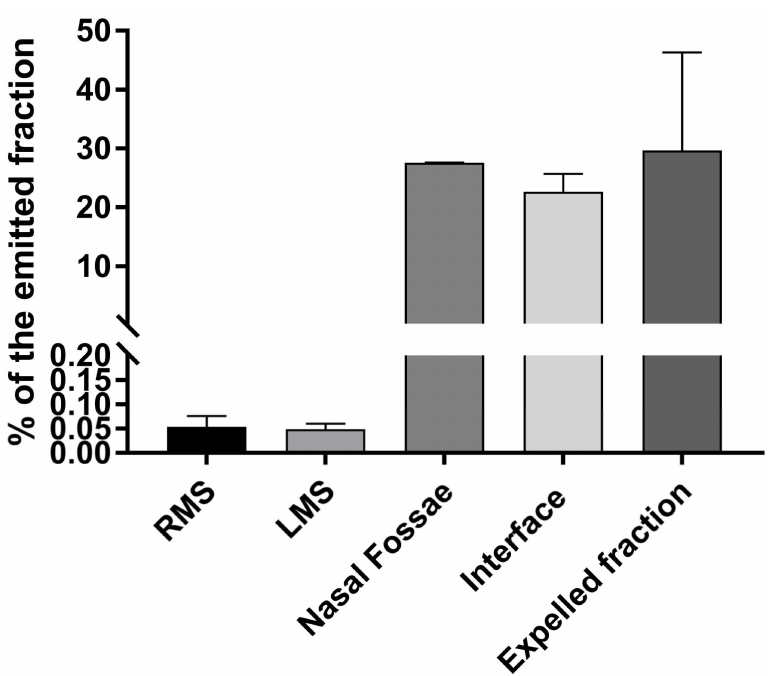
Figure 5. Results obtained after 99m Tc-DTPA nebulization with the PARI SINUS (closed soft palate condition). Results are expressed as percentage of the emitted